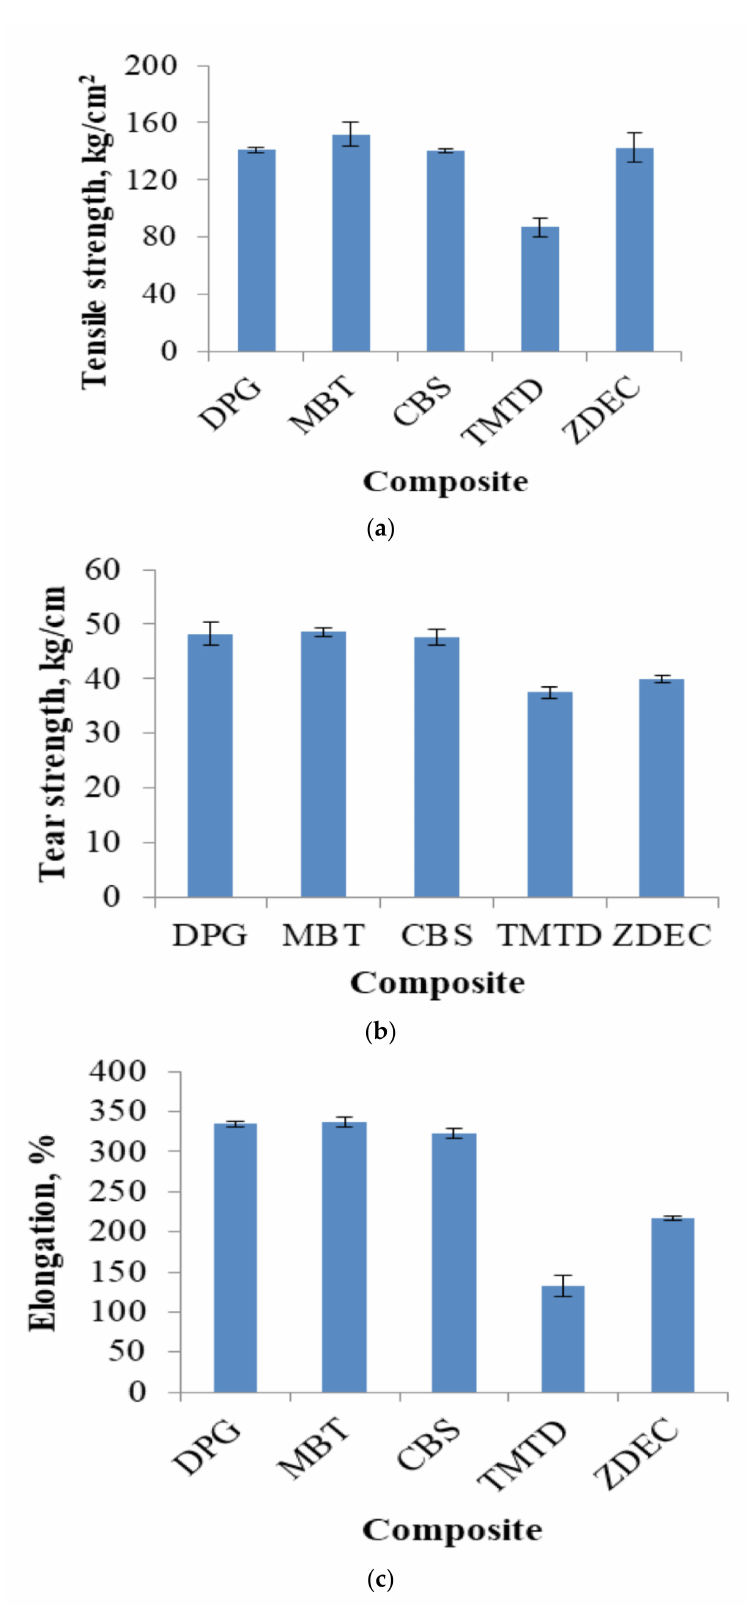
Figure 32. Mechanical properties of NBR/EPDM rubber composites: ( a ) tensile strength; ( b ) tear strength, and; ( c ) elongation